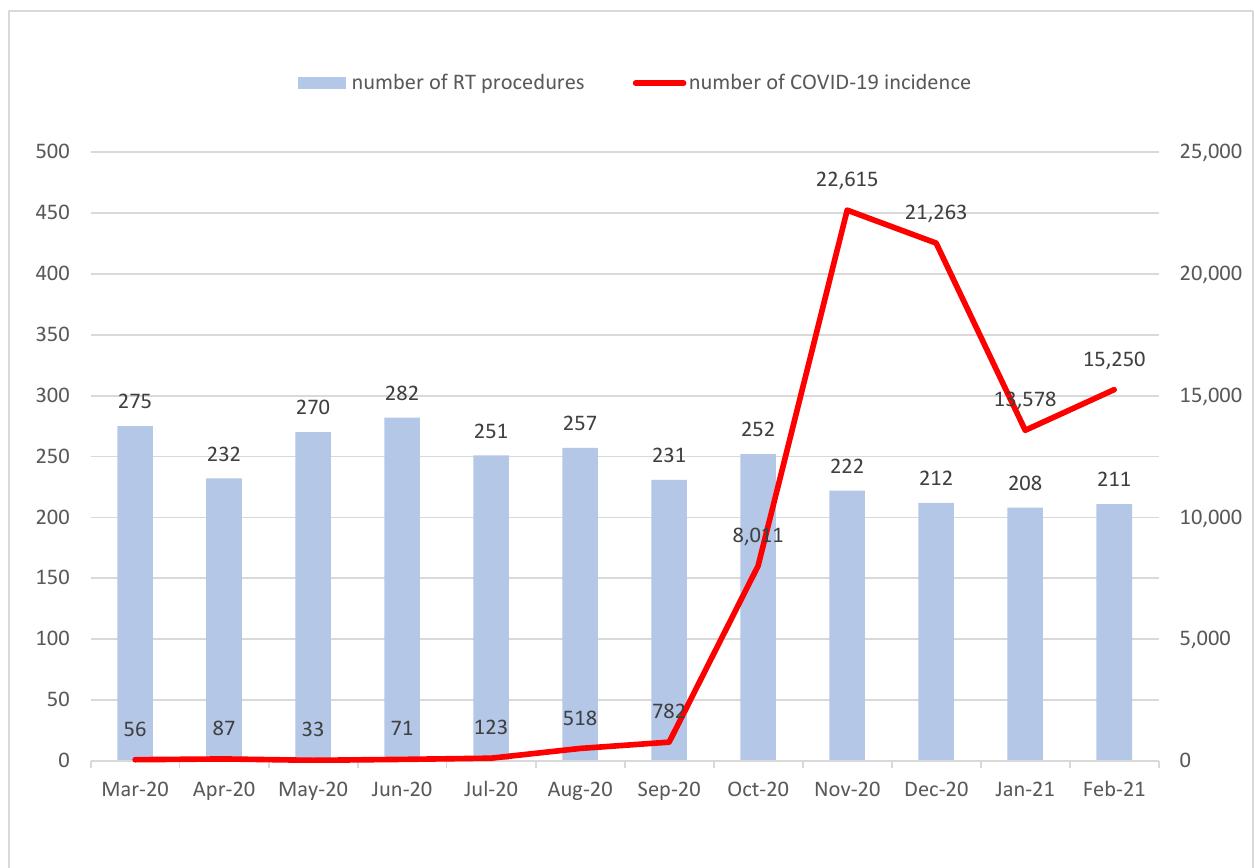
Figure 5. The correlation between the number of RT procedures in Warmia and Masuria voivodeship and the COVID-19 incidence during the first year of the pandemic.